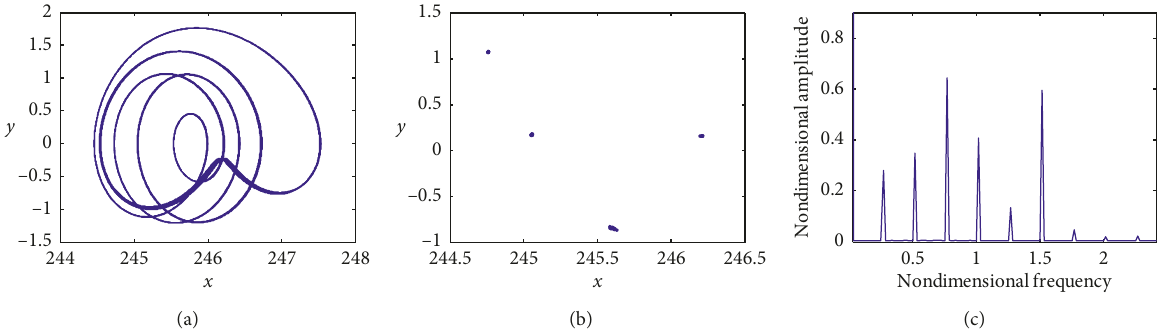
Figure 9: Dynamic response ( f � 1 . 0): (a) phase portrait; (b) Poincar´e map; (c) frequency spectrum. 2